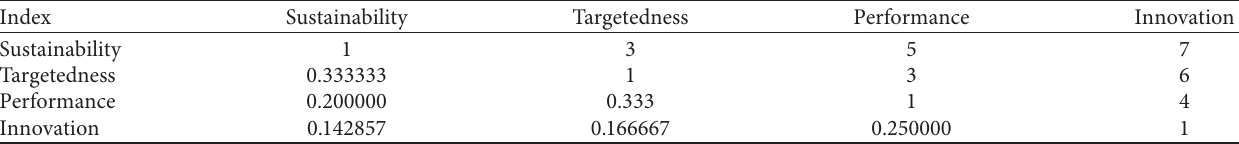
Table 2: Weights of the four factors at the criterion